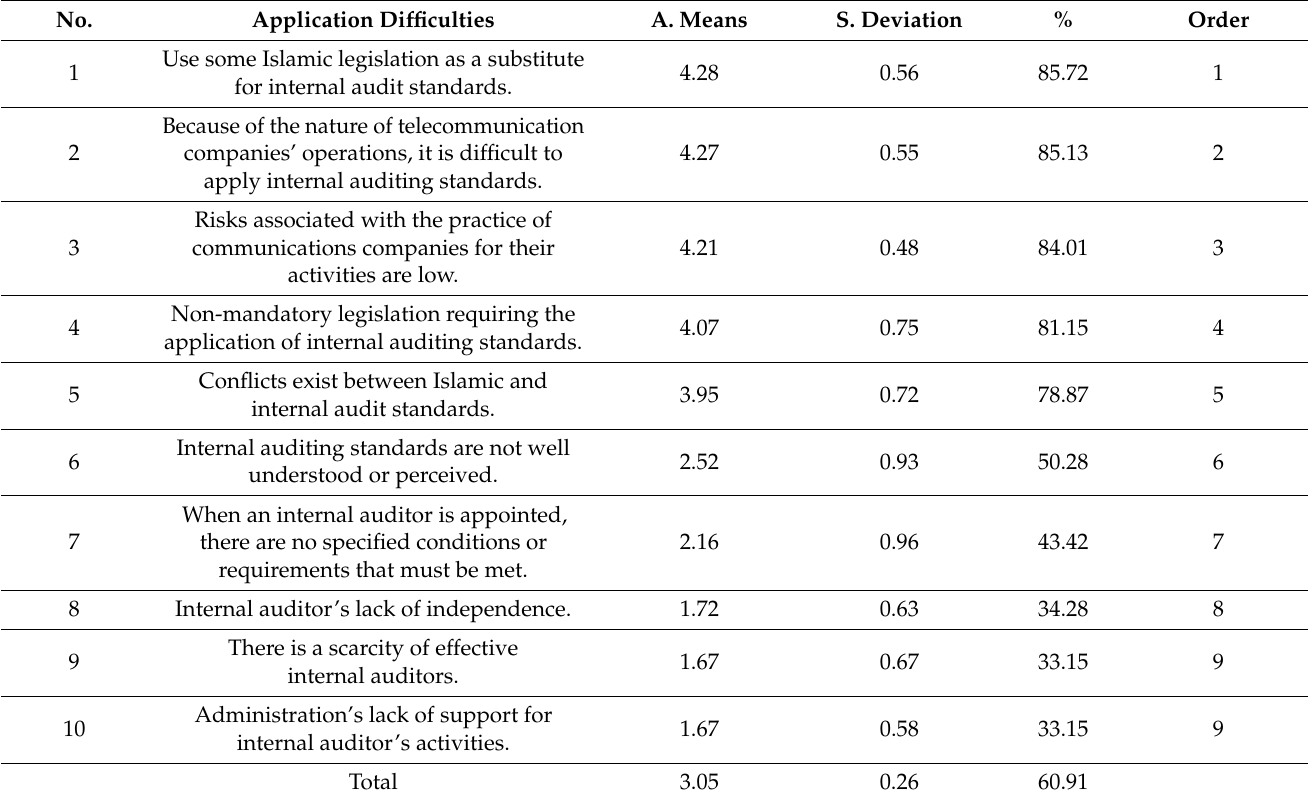
Table 6. The outcomes of Application